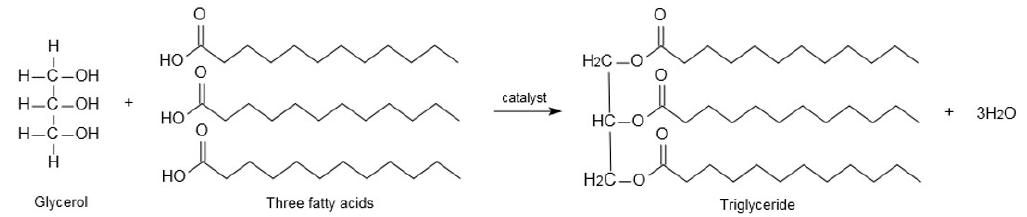
Figure 2. Chemical formation of triglyceride by esterification of glycerol with fatty acids.